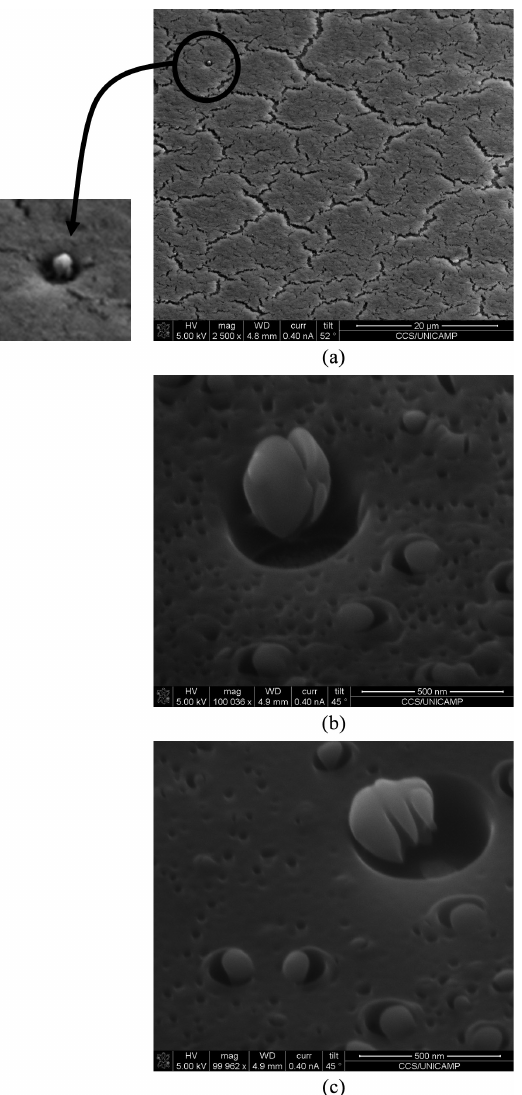
Figure 7. SEM images of structures grown at 79 mTorr C 3nm Ni catalytic film (sample 79Ni, uppermost picture) and at 100 mTorr C H onto 3nm Ni (b) and Cu (c) catalytic films. The inset 2 2 is a magnified picture of the region showing a